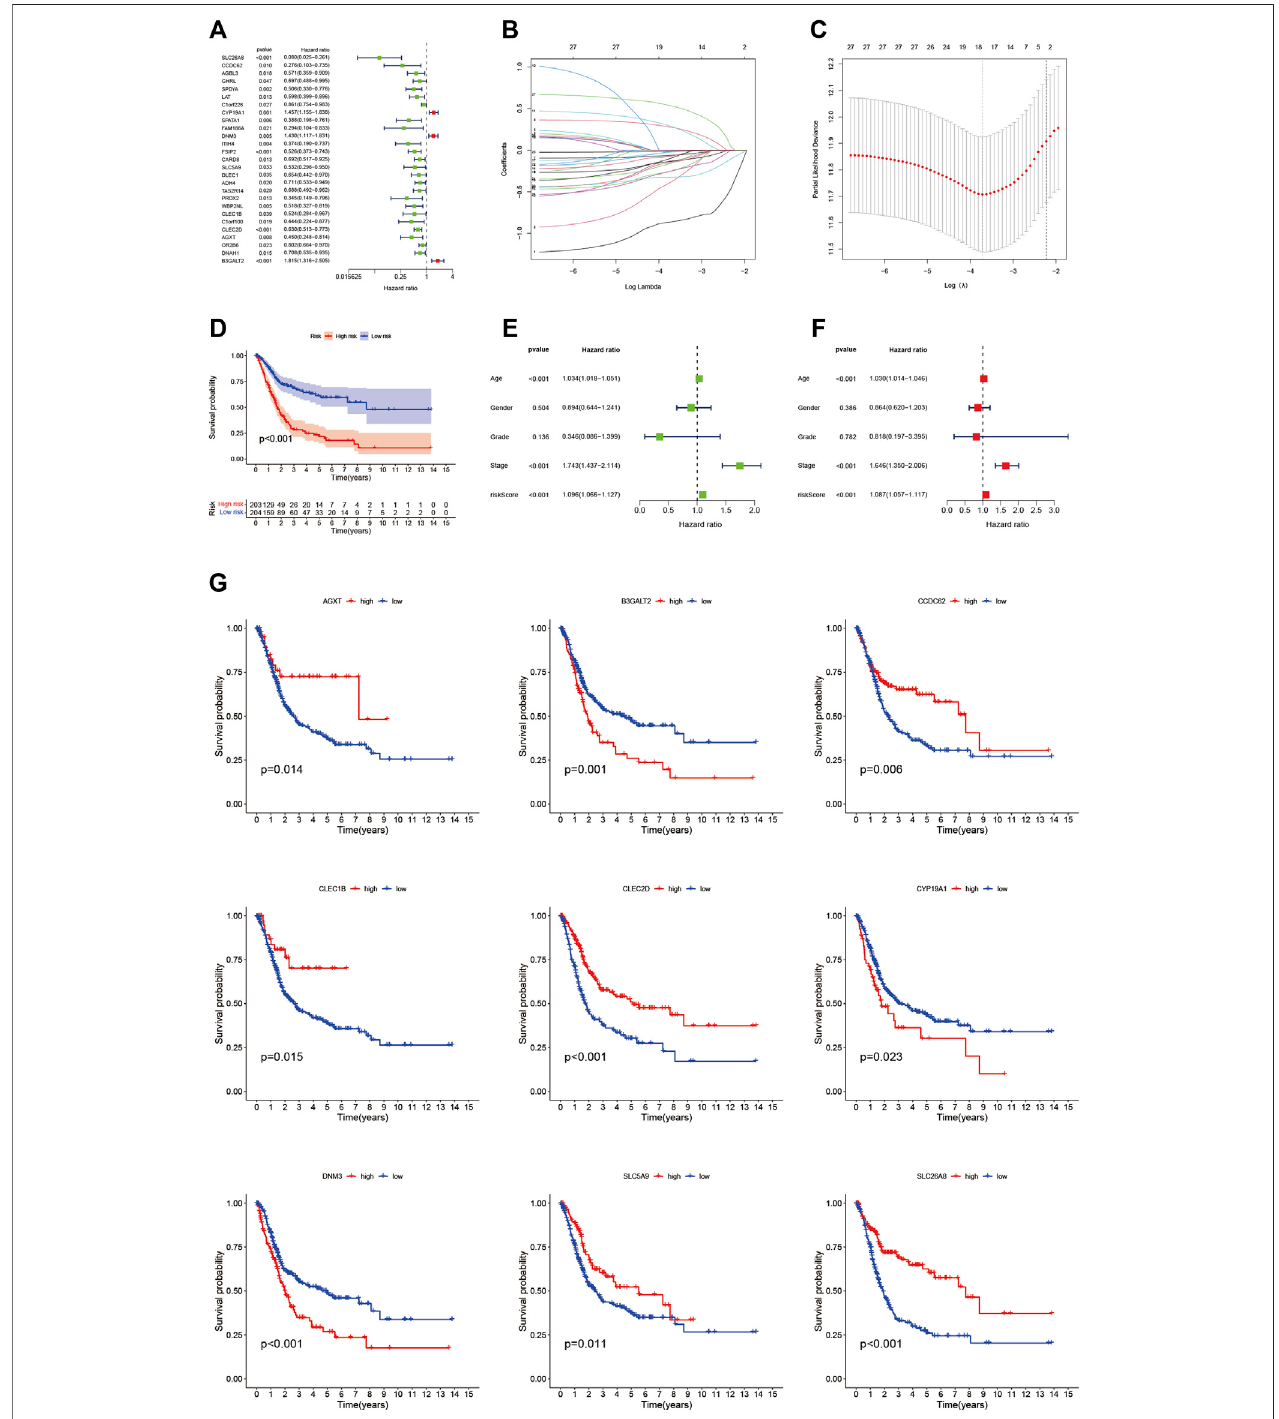
FIGURE3|(A) Nomogrambetween27eosinophil-relatedgenesandoverallsurvivalscreenedbyunivariateCoxregressionanalysis (B) LASSOcoef fi cientpro fi les of 22 candidate genes. A vertical line is drawn at the value chosen by 10-fold cross-validation (C) Ten-fold cross-validation for tuning parameter selection in lasso regression. Vertical lines are drawn from the best data according to the minimum criterion and 1 standard error criterion. The vertical lines on the left represent the fi nal 9 genes identi fi ed (D,G) Kaplan-Meier curve analysis showing the difference in overall survival between high-risk and low-risk groups (E) Univariate Cox regression results for overall survival (F) Multivariate Cox regression results for overall survival.